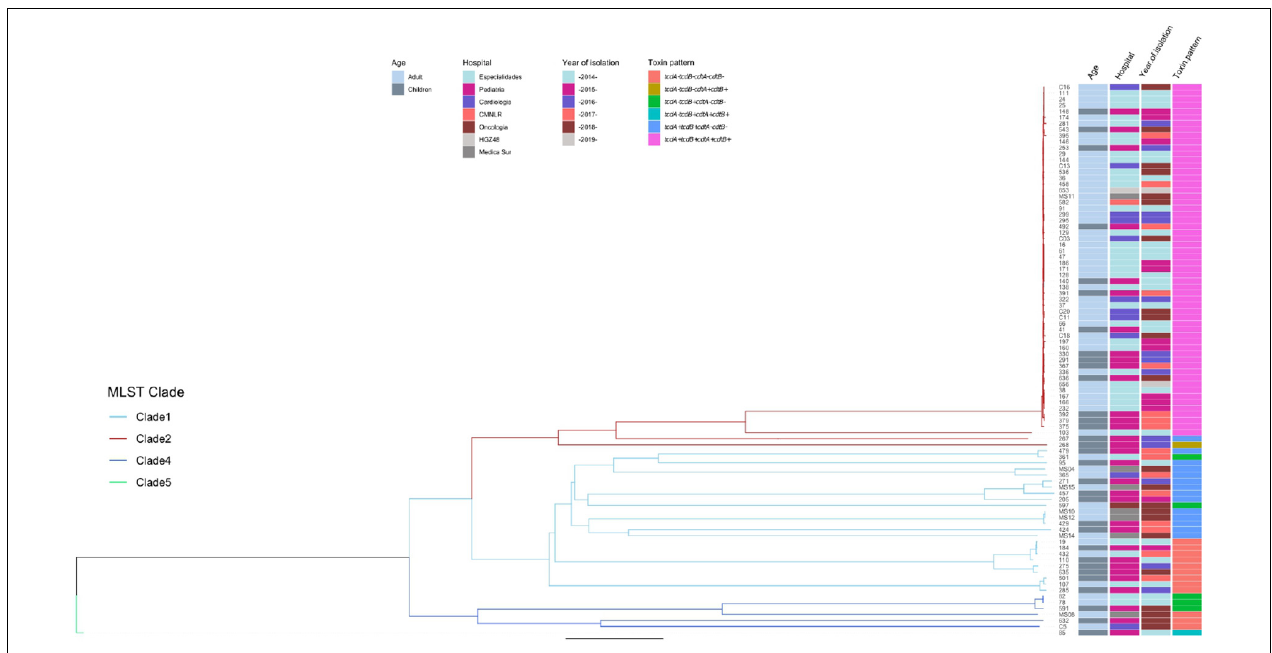
FIGURE 5 | Neighbor Joining phylogenetic tree based on the cgMLST allelic profiles determined by EnteroBase and its relationship with other epidemiological variables. Columns on the right describe: Strain number, age of the patient, hospital, year of isolation and toxins profile are shown in relation to the cgMLST and MLST clades. MLST Clades are colored in the phylogenetic tree, Clade 1 blue, Clade 2 red, Clade 4 dark blue, and Clade 5